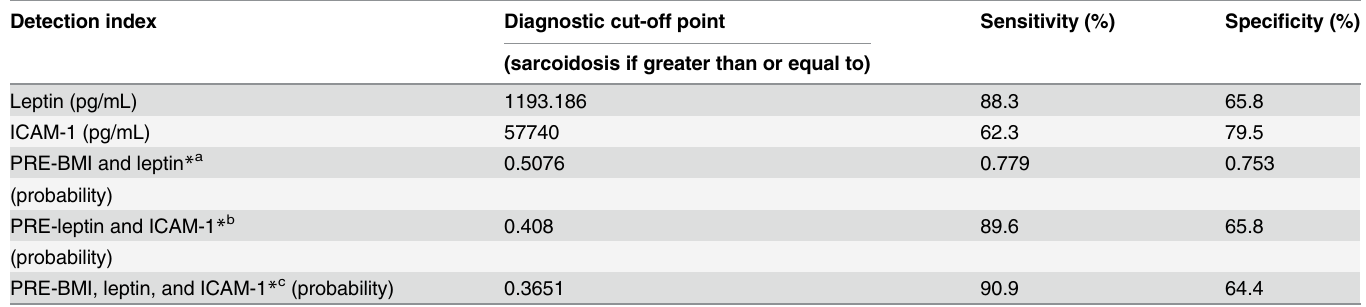
Table 6. Cut-off values, sensitivity, and specificity of ROC curves for differential diagnosis of SA and TB. Detection index